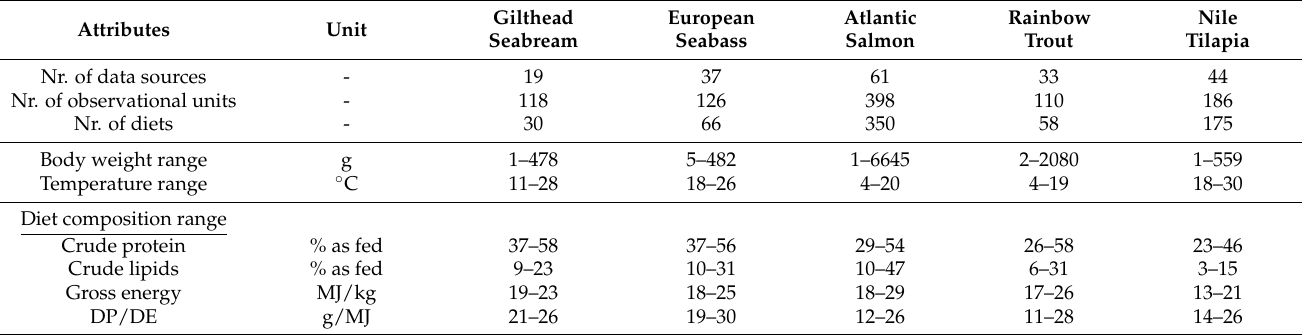
Table 1. Overview of the data used to calibrate and validate the model for each